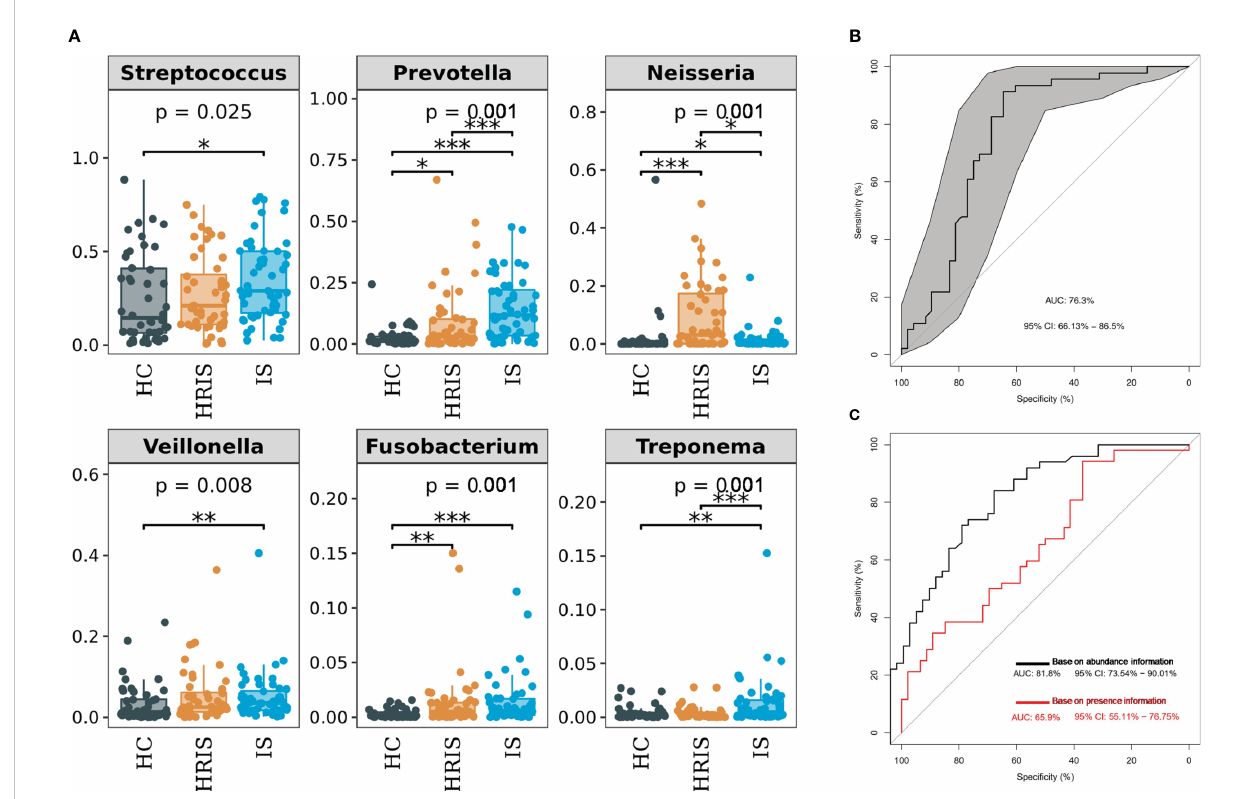
FIGURE 4 Differentiated bacteria of subjects with IS, HRIS and HC in genus level. (A) Comparison of a -diversity between the oral microbiota in three groups. (B) Machine learning for classi fi cation of HRIS and HC based on oral microbiota using the random forest algorithm. (C) Machine learning for classi fi cation of IS and HC based on oral microbiota using the random forest algorithm. *: P value ≤ 0.05; **: P value ≤ 0.01; ***: P value ≤